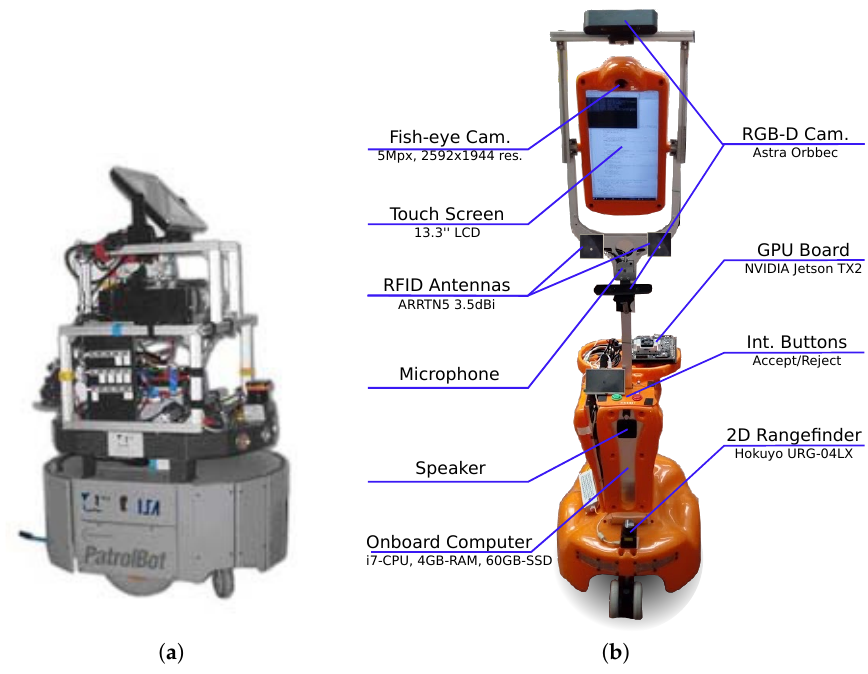
Figure 2. The robots employed in the experiments: ( a ) Rhodon; and ( b )